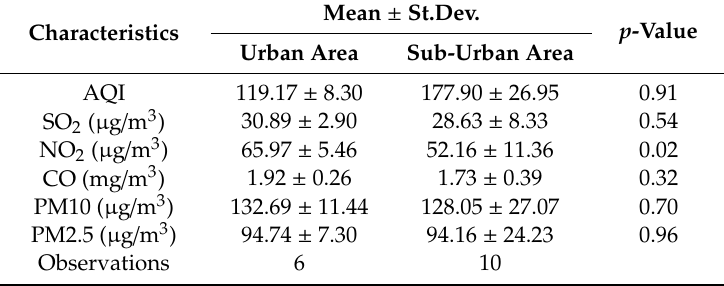
Table A1. Comparison of air pollutants between urban and sub-urban areas in